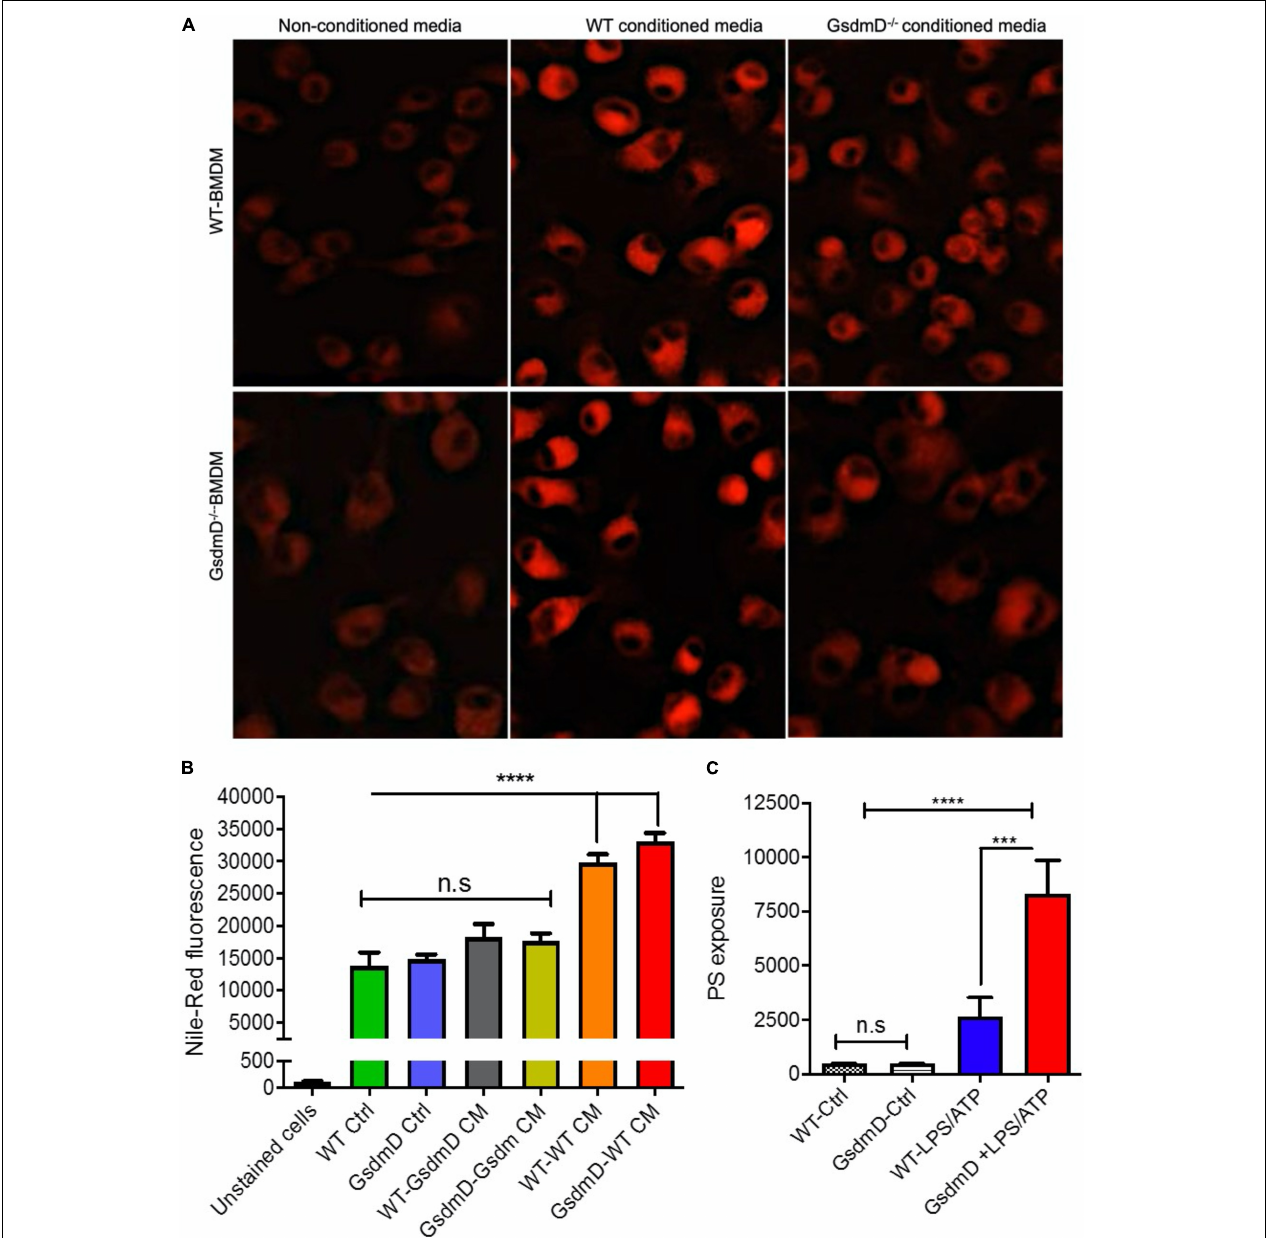
FIGURE 3 | Gasdermin D (GsdmD) promotes foam cell formation. (A) BMDMs isolated from WT or GsdmD - / - mice were loaded with 50 µ g/ml AcLDL +25 µ g/ml OxLDL for 48 h ± conditioned media isolated from LPS/ATP treated WT or GsdmD - / - BMDMs. The culture media was removed, cells were washed with PBS, and stained with Nile-red dye (0.25 µ g/ml) at 37 ◦ C for 15 min. The stained cells were washed thoroughly with PBS and fixed with paraformaldehyde and imaged using fluorescent microscope with TRITC filter (Excitation/emission: 550/640 nm). (B) Quantification of Nile-red staining in WT or GsdmD - / - BMDMs ± conditioned media by flow-cytometry, mean ± SD, N = 4, **** represent p < 0.0001 by ANOVA Bonferroni post-test. (C) BMDMs isolated from WT or GsdmD - / - mice were loaded with 50 µ g/ml AcLDL +25 µ g/ml OxLDL for 48 h. The foam cells were left untreated or treated with LPS + ATP to induce Nlrp3 inflammasome. The cells were